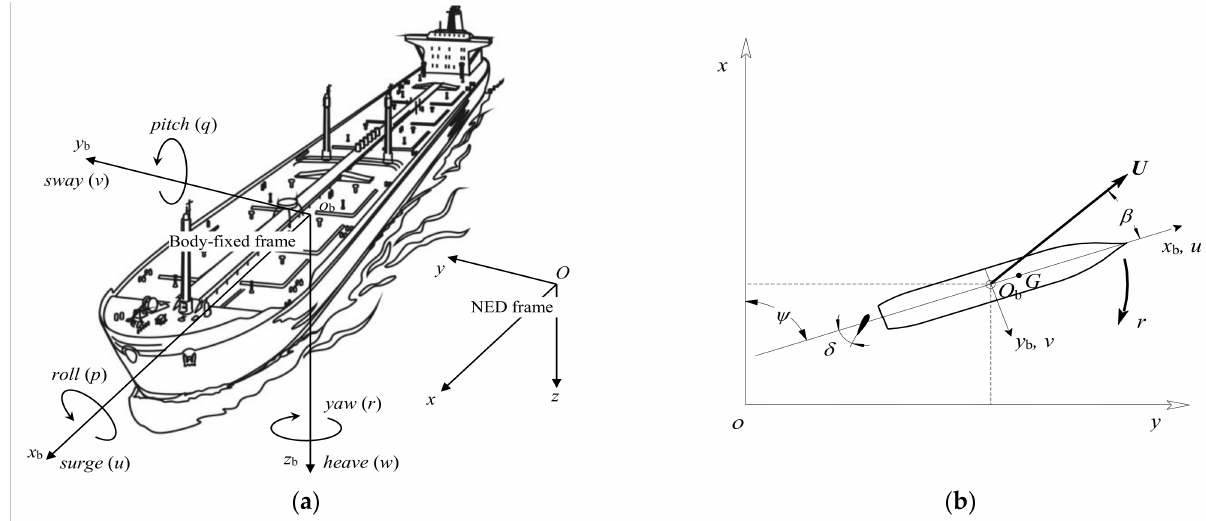
Figure 1. Ship motion coordinate systems. ( a ) 6 Degree-of-freedom (DOF) ship motion, ( b ) 3DOF ship motion in the horizontal